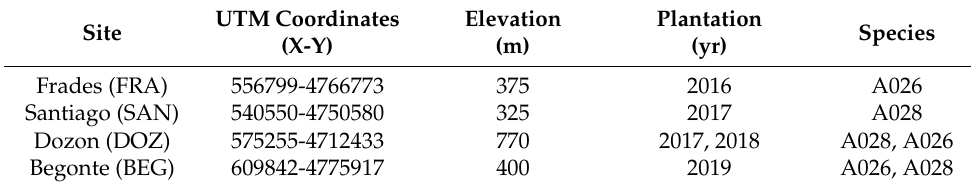
Table 1. Description of the experimental (UTM coordinates: Coordinates of the upper left corner of the plot, Elevation: meters above sea level (masl), Plantation: year of plantation, Species: A026 ( P. pinaster ) and A028 ( P. radiata